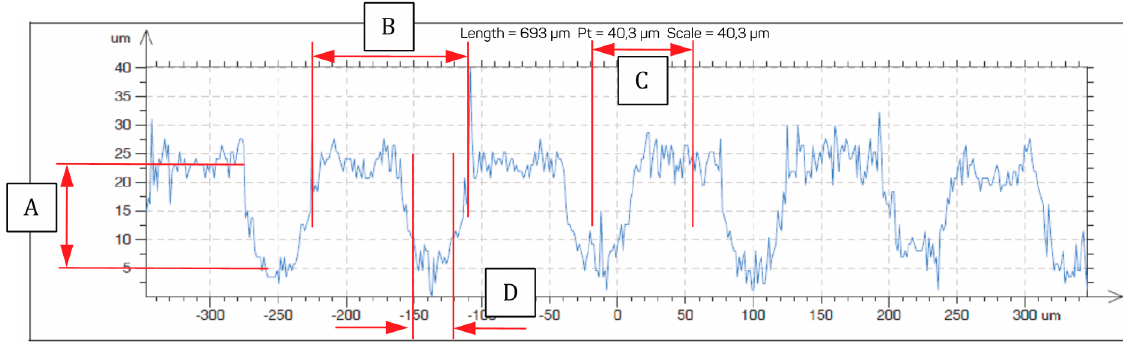
Figure 2. Notch profile on a sample zirconia surface. Table 1. Dimension characteristics for A, B, C, D, E, F, and G adopted for the tests. Measurement